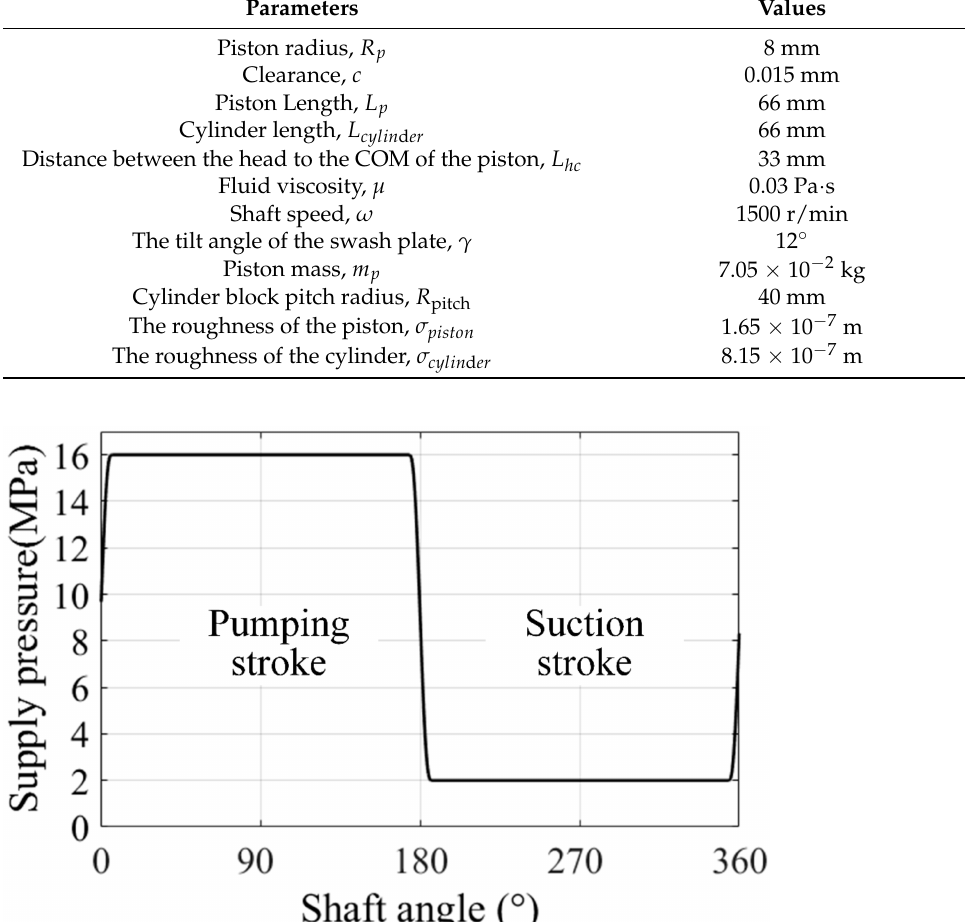
Table 1. Parameters for the piston-cylinder assembly used in the analysis.